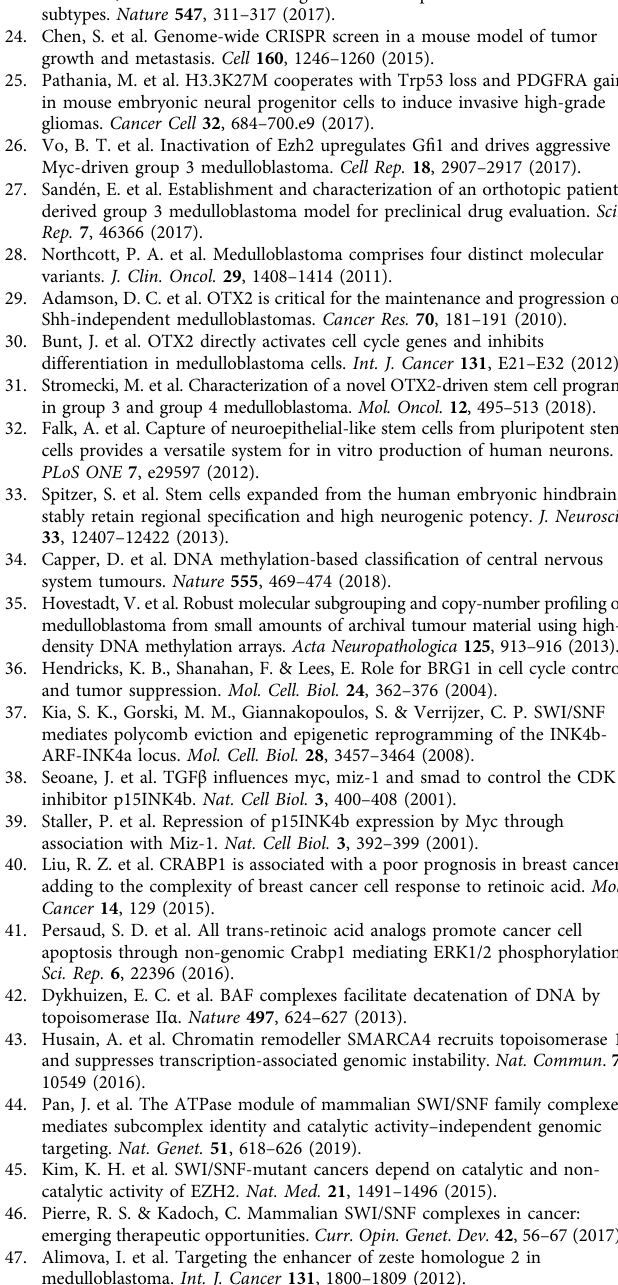
Fig. 7 EZH2 inhibition with Tazemetostat increases cell death of OM-derived tumor spheroids and in MB organoids. a Histograms show FACS analysis of OM-induced tumor spheroids cell death (late and early apoptosis) after 1 day of drug treatment (DMSO, Tazemetostat, GSK-126). b Histograms show FACS analysis of OM-induced tumor spheroids (cell cycle analysis) after 1 day of drug treatment (DMSO, Tazemetostat, GSK-126). c Histograms show FACS analysis of OM-induced tumor spheroids cell death (late and early apoptosis) after 3 days of drug treatment (DMSO, Tazemetostat, GSK-126). d Representative FACS analysis of OM-induced tumor spheroids cell death (late and early apoptosis) after 3 days of drug treatment (DMSO, Tazemetostat, GSK-126). e Histograms show FACS analysis of OM-induced tumor spheroids (cell cycle analysis) after 3 days of drug treatment (DMSO, Tazemetostat, GSK-126). f Representative FACS analysis of OM-induced tumor spheroids (cell cycle analysis) after 3 days of drug treatment (DMSO, Tazemetostat, GSK-126. g Quanti fi cation of cerebellar organoids at day 41, electroporated at day 35 with pPBase + pPBMyc + pPBOtx2 + pPBVenus (OM), and treated for 5 days with either DMSO or Tazemetostat or GSK-126. Percentage of active caspase-3-positive cells between Venus-positive